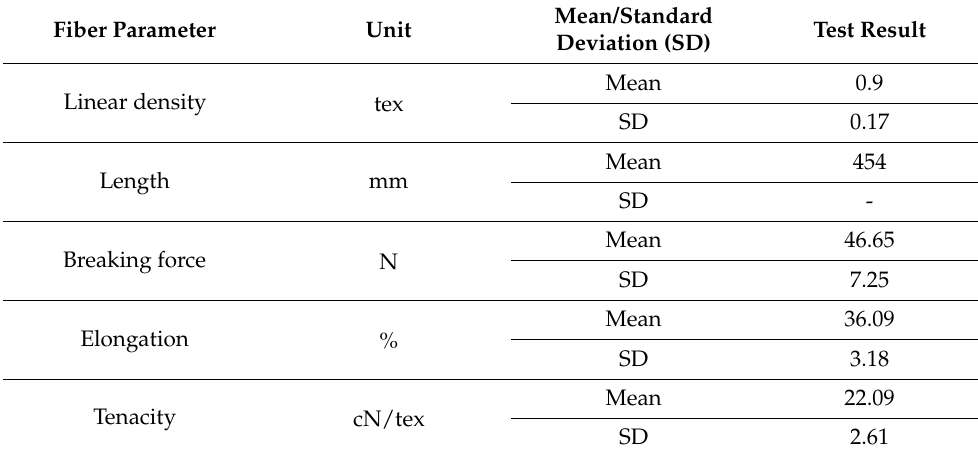
Table 1. Hemp fiber parameters.